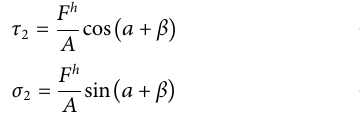
Frontiers in Earth